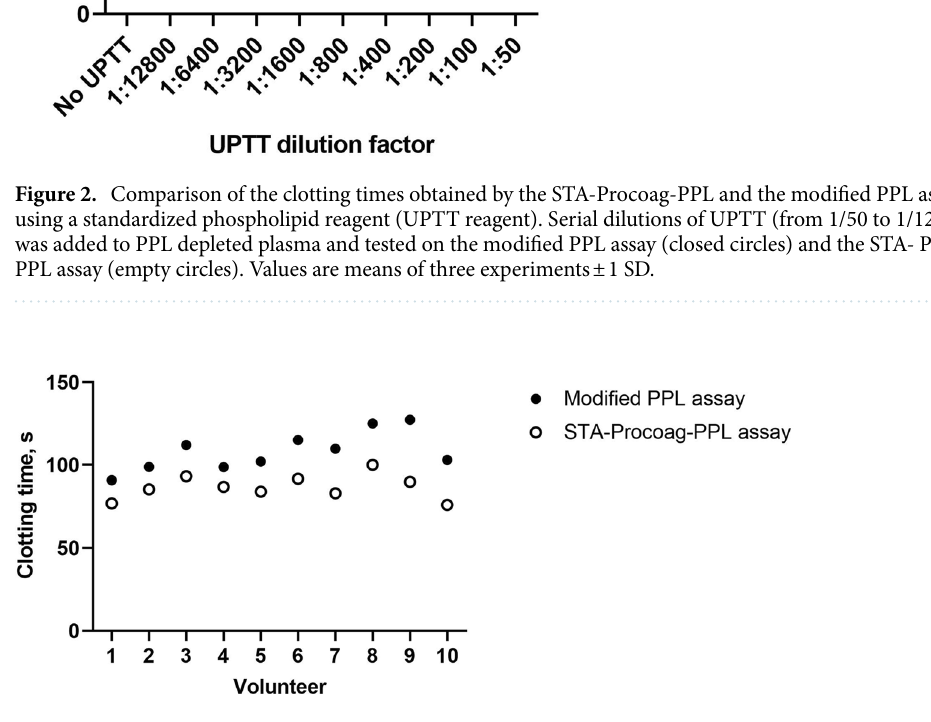
Figure 3. Comparison of PPL clotting times (PPL CT ) measured by the modified PPL assay (closed circles) and the STA-Procoag-PPL kit (empty circles). Platelet free plasmas from 10 healthy individuals were tested on both assays and the PPL CT is presented in seconds (s). Values are mean of duplicate